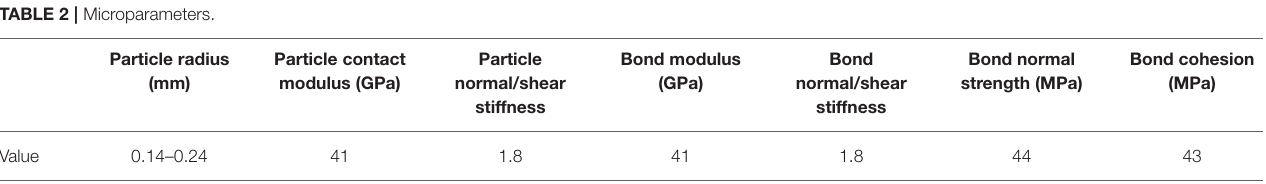
FIGURE 1 | Deformability and strength of a flat-joint contact. (A) normal stiffness, (B) shear stiffness, and (C) strength criterion. TABLE 2 |